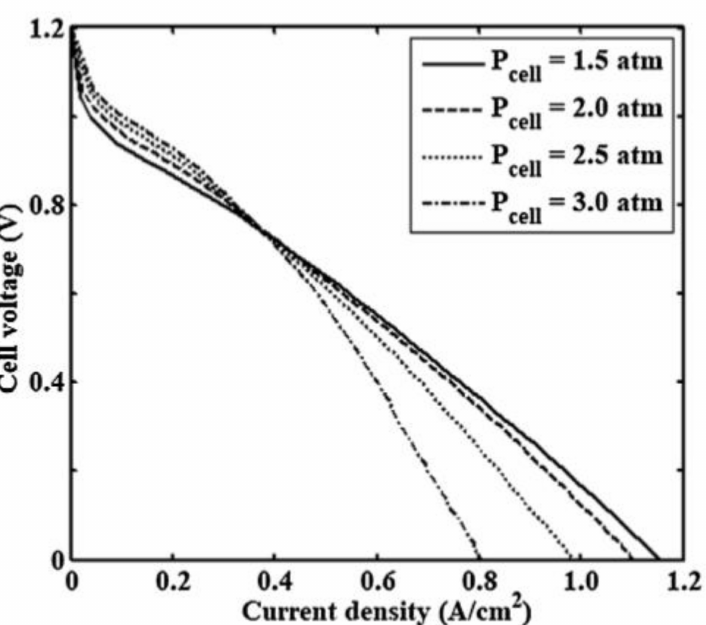
Figure 2. The effect of different cell operating pressures on the polarization curve (Reprinted with permission from Ref. [35], license No.